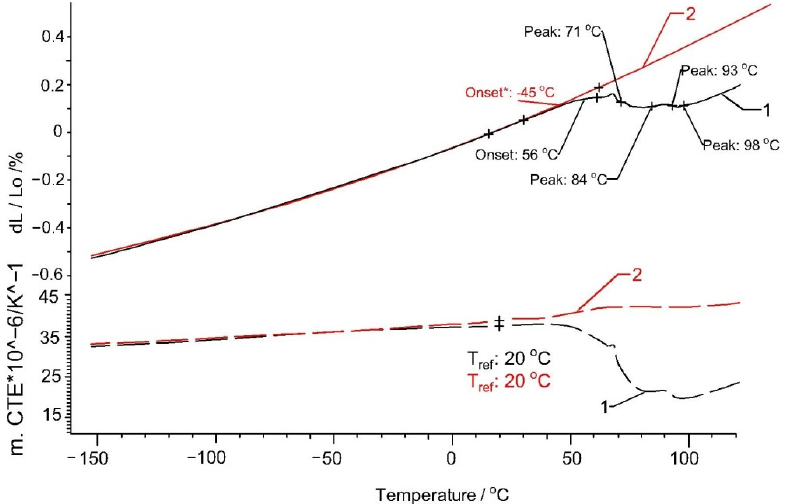
Figure 6. Thermal expansion (solid lines) and coefficient of thermal expansion of the sample Arboform ® LV3 Nature: 1—first heating; 2—second heating.